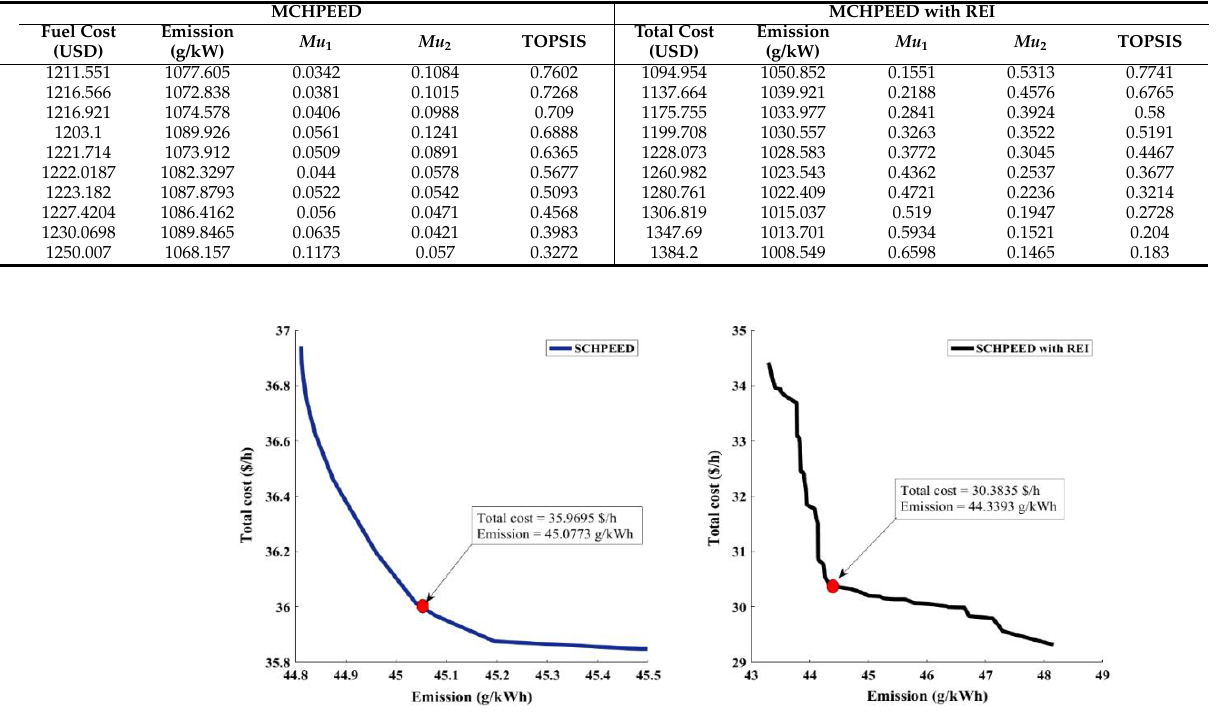
Table 8. Top ten optimal front solutions.